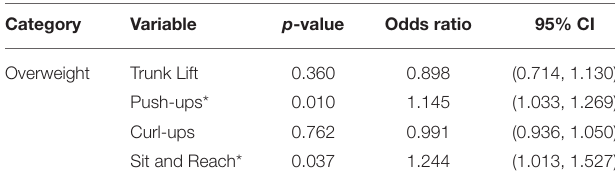
TABLE 9B | Associations between musculoskeletal fitness and weight status in kindergarten through second grades (reference group: obese).